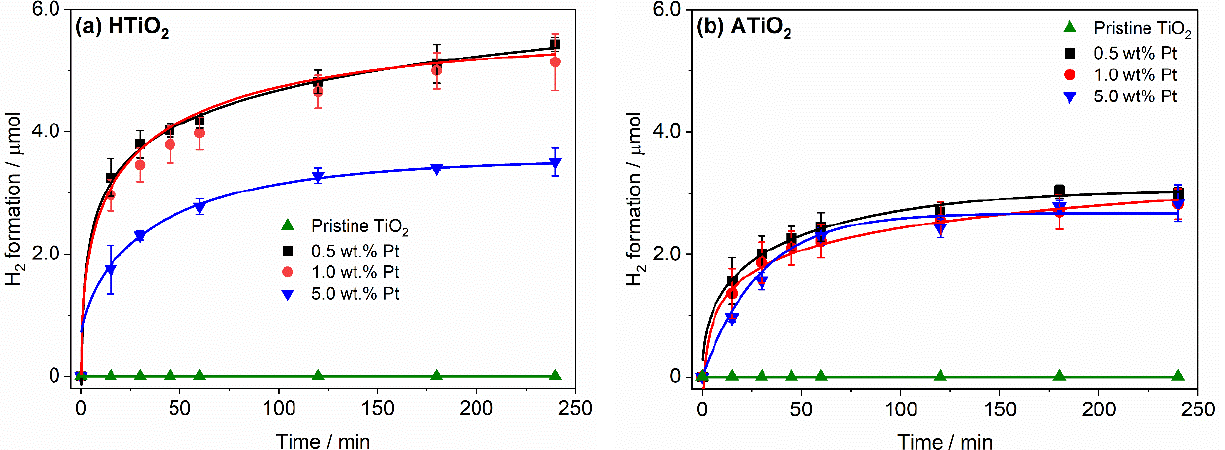
Figure 4. Comparison of molecular hydrogen formation during light ‐ induced reforming of naphthalene in the presence of pristine TiO 2 and 0.5, 1.0, and 5.0 wt% Pt ‐ TiO 2 . ( a ) HTiO 2 and ( b ) ATiO 2 after 240 ‐ min illumination using simulated solar light. Photocatalyst mass concentration, 1 g L − 1 ; 156 μ M aqueous solution of naphthalene.